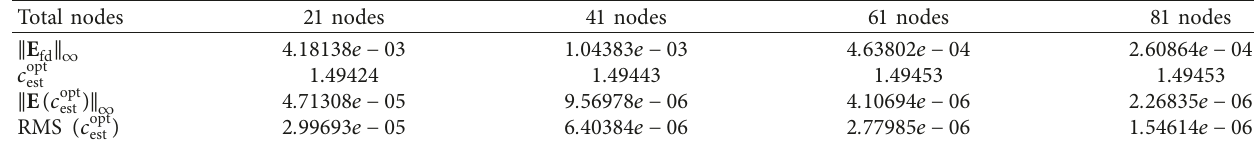
Table 3: Comparing c opt est and its related errors for problem (20).